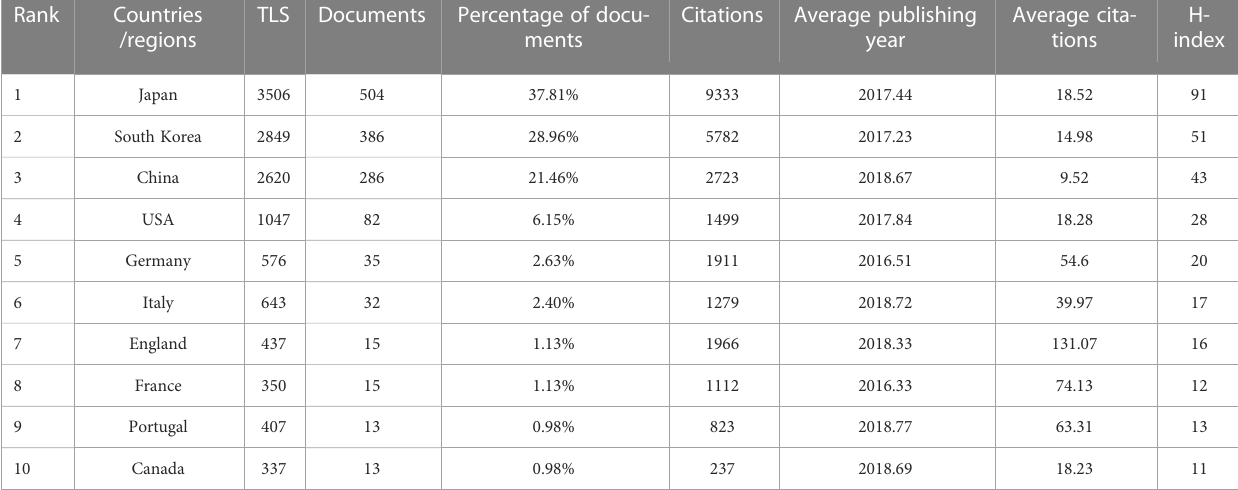
TABLE 1 Top 10 productive countries/regions related to the endoscopic application in early gastric cancer. Rank Countries TLS Documents Percentage of docu- /regions